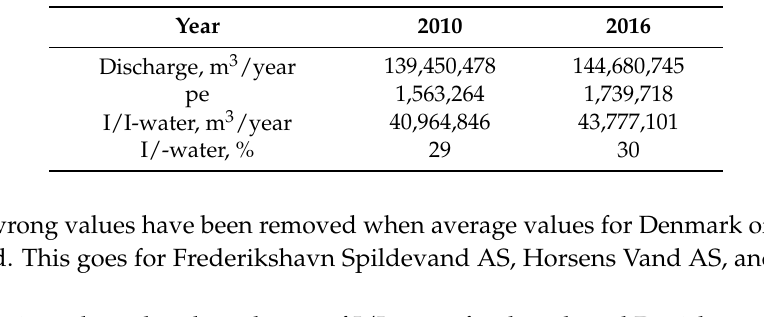
Table 9. Calculated average values of I/I-water for some big Danish wastewater districts for 2010 and 2016.